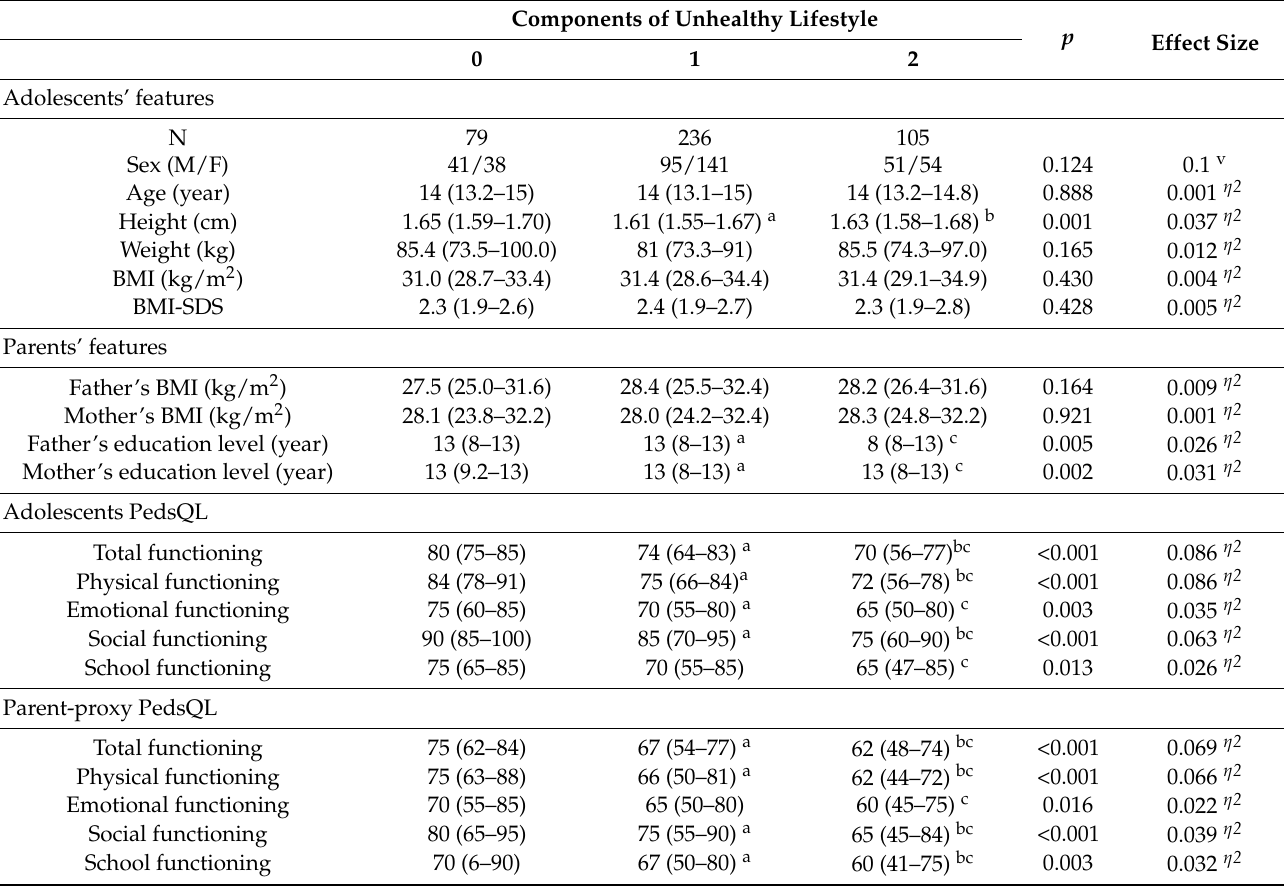
Table 4. Demographic and anthropometric features of participants and adolescents’ self-reported and parent-proxy reported PedsQL scores by clusters of unhealthy lifestyle